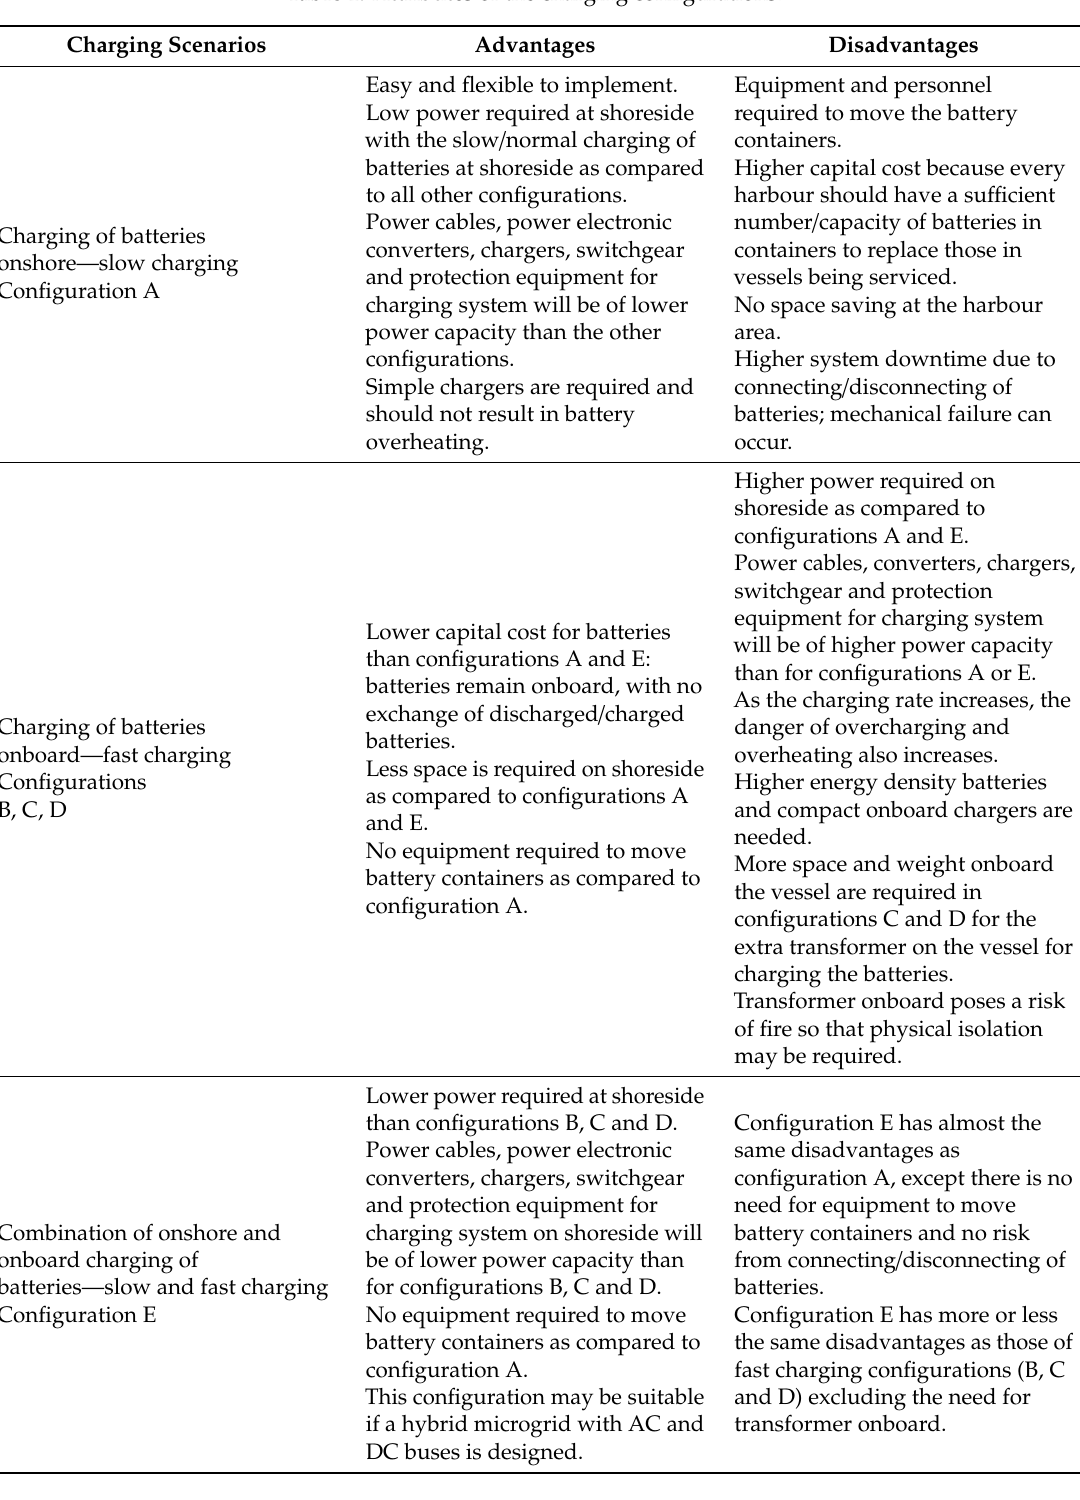
Table 1. Attributes of the charging